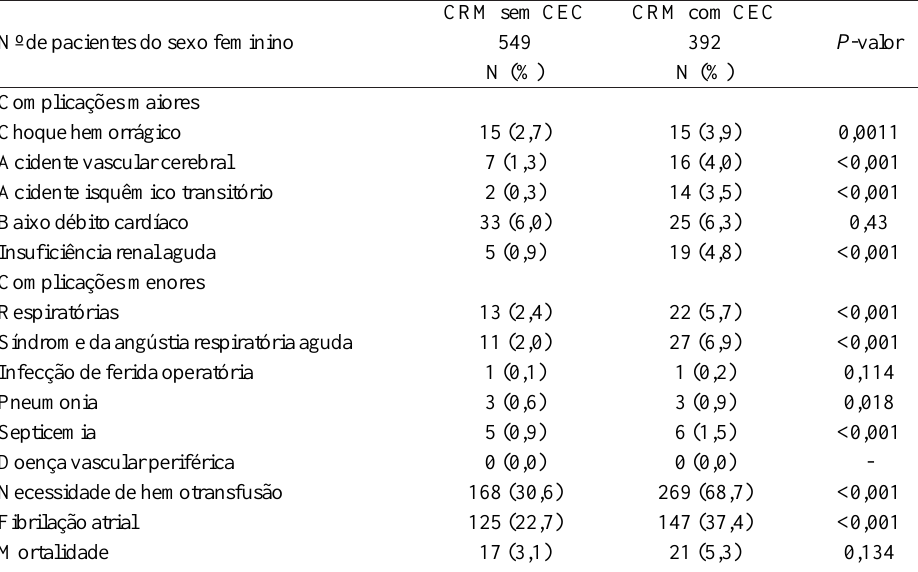
Tabela 3. Descrição das complicações maiores e menores e taxa de mortalidade em mulheres